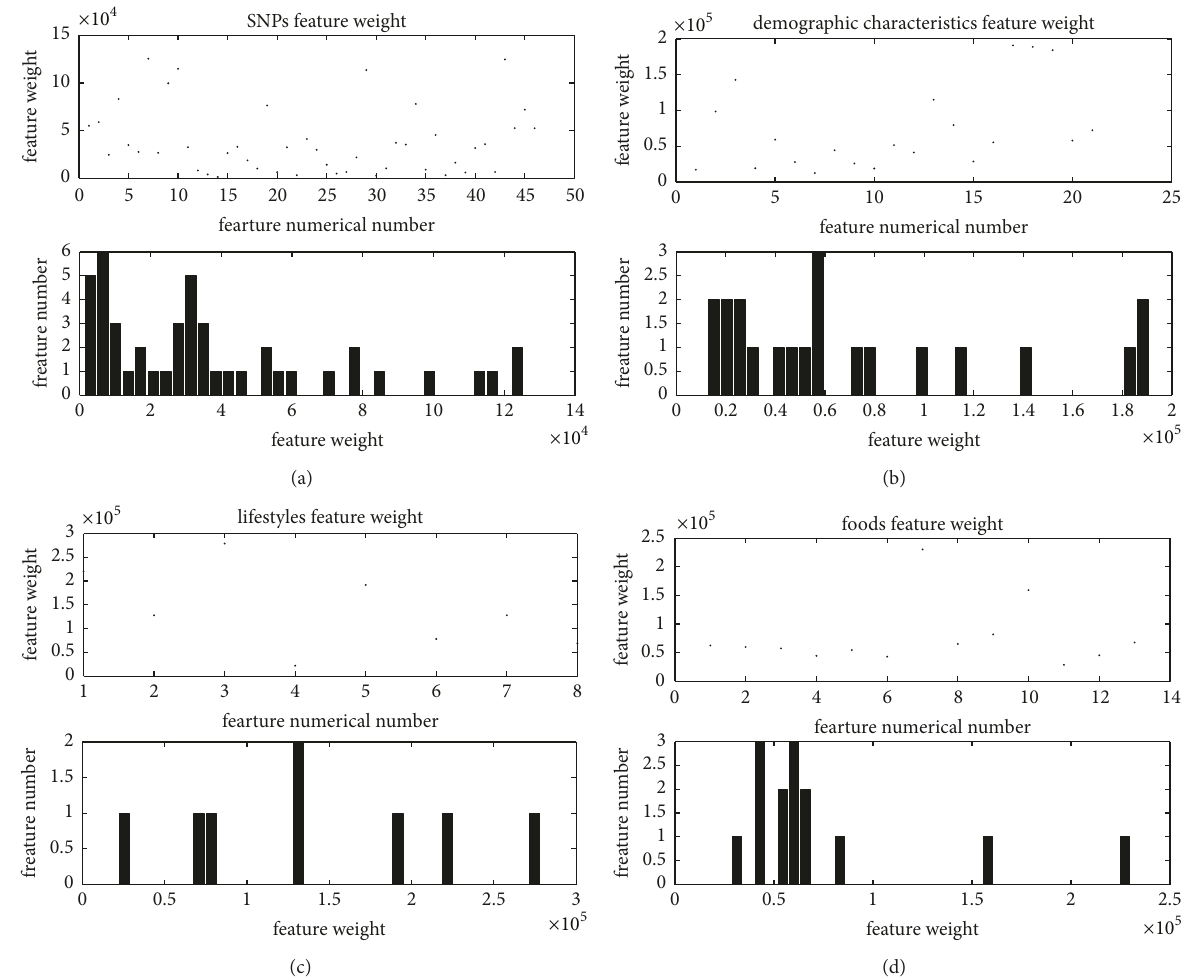
Figure 3: Feature selection by relief algorithm: (a) SNPs feature (note: the feature numerical number in the upper figure is regarding Supplementary S1 from columns B(1) to AU(46)), (b) demographic characteristics feature (note: the Feature numerical number in the upper figure is regarding Supplementary S2 from columns A(1) to U(21)), (c) lifestyle feature (note: the feature numerical number in the upper figure is regarding Supplementary S3 from columns B(1) to I(8)), and (d) food feature (note: the feature numerical number in the upper figure is regarding Supplementary S4 from columns B(1) to